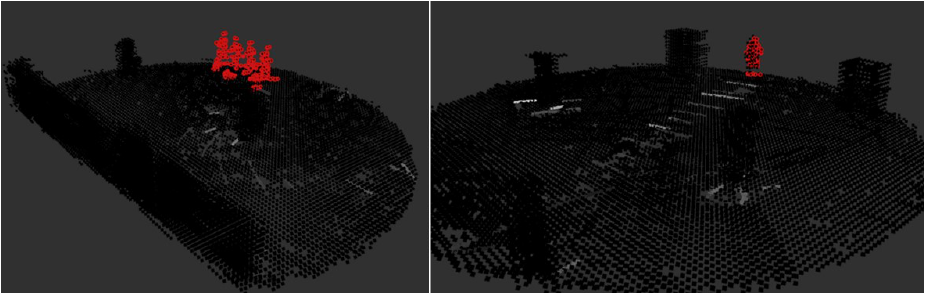
Figure 14. Discrimination of dynamic objects (red points) in the region of interest (black points).